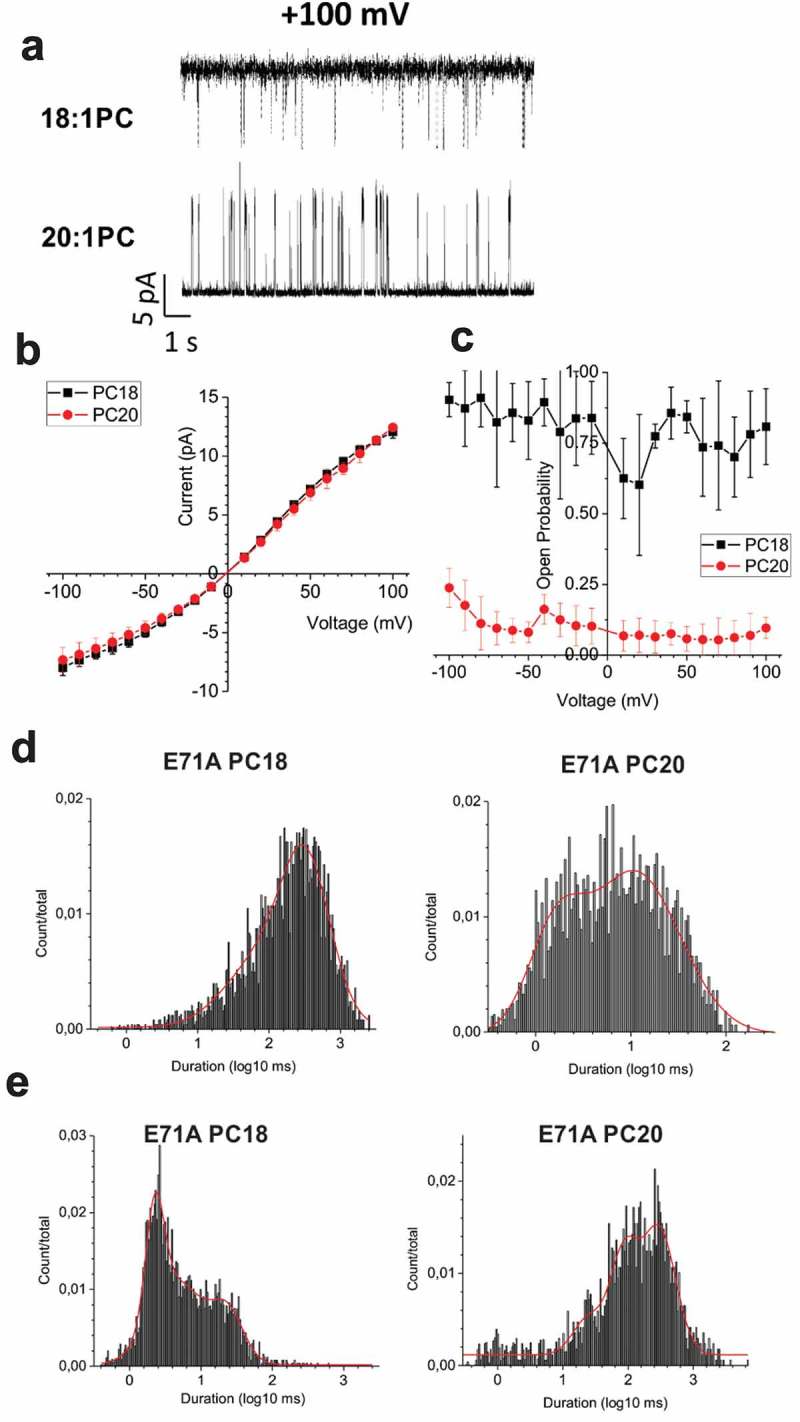
Single channel properties of E71A KcsA in lipid bilayers of different thickness. (a) Representative single channel traces at +100 mV E71A KcsA channels in bilayers composed of 30 mol% POPG and 70 mol% diC18:1PC (top) or diC20:1PC (bottom). (b) The unitary conductance of KcsA E71A channels are unchanged by variations in bulk lipid acyl tail length. (c) The open probability E71A is higher in diC18:1PC/POPG bilayers (right). (n ≥ 3). All-point histograms of open (d) and closed (e) dwell times of E71A channels at +100 mV in 30 mol% POPG + 70 mol% diC18:1PC or diC20:1PC.